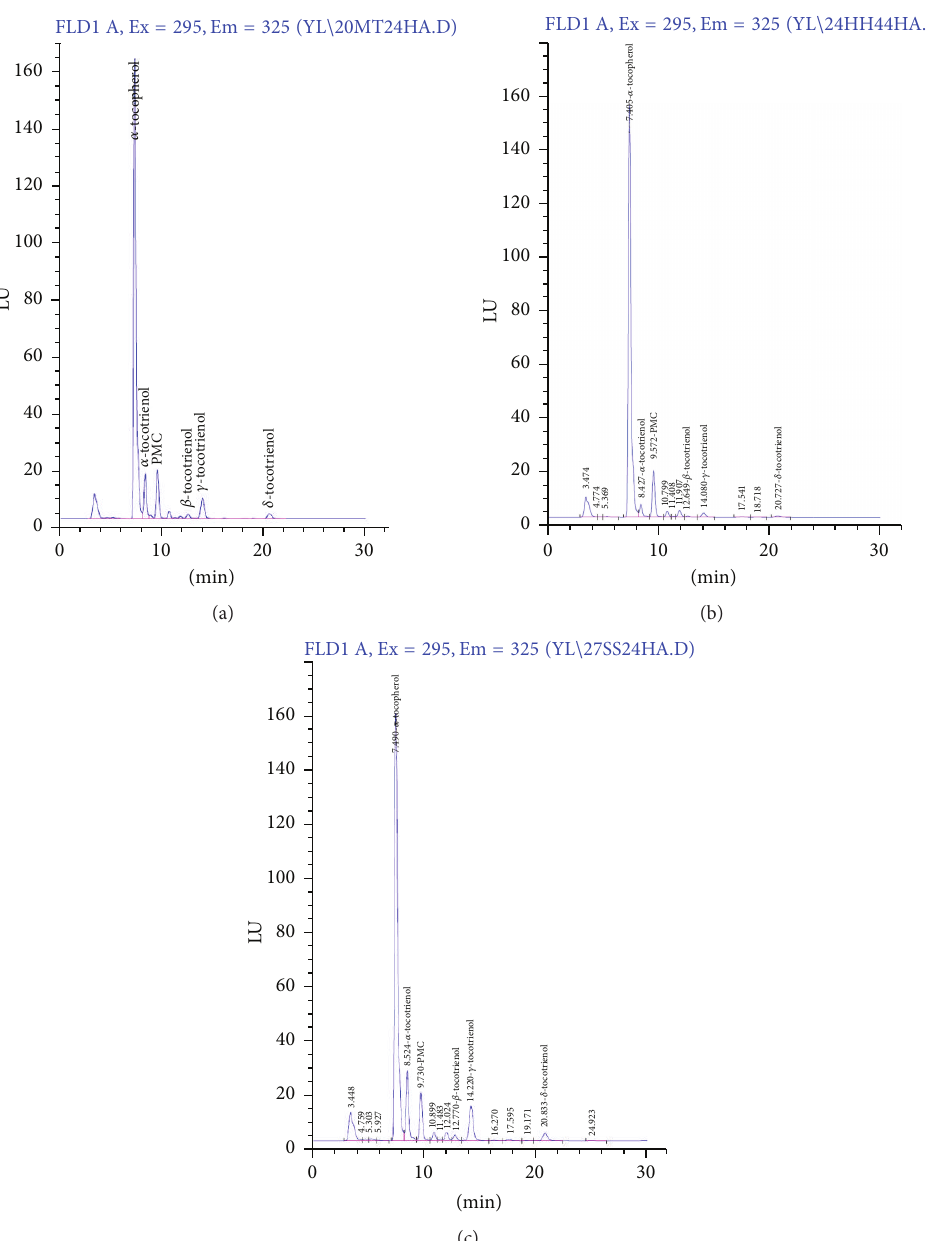
Figure 2: Chromatograms for human plasma of three male volunteers (a–c) after consumption of 200 mg mixed tocotrienols.